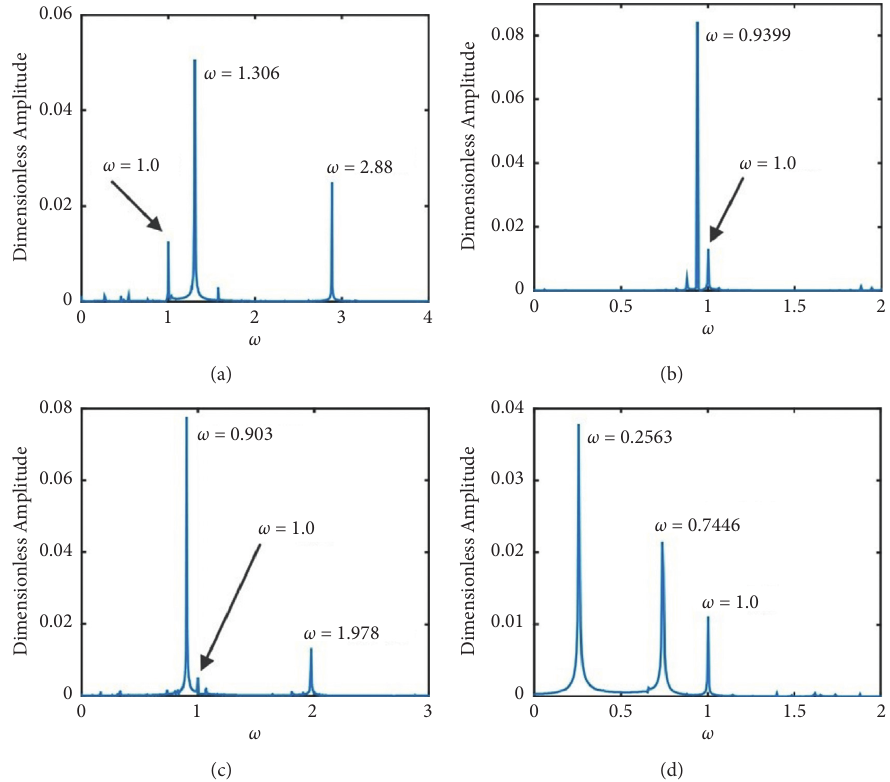
Figure 5: Spectrums of the responses at (a) λ � 1 . 88, (b) λ � 2 . 67, (c) λ � 5 . 42 (run-up), and (d) λ � 5 . 42 (run-down) when N